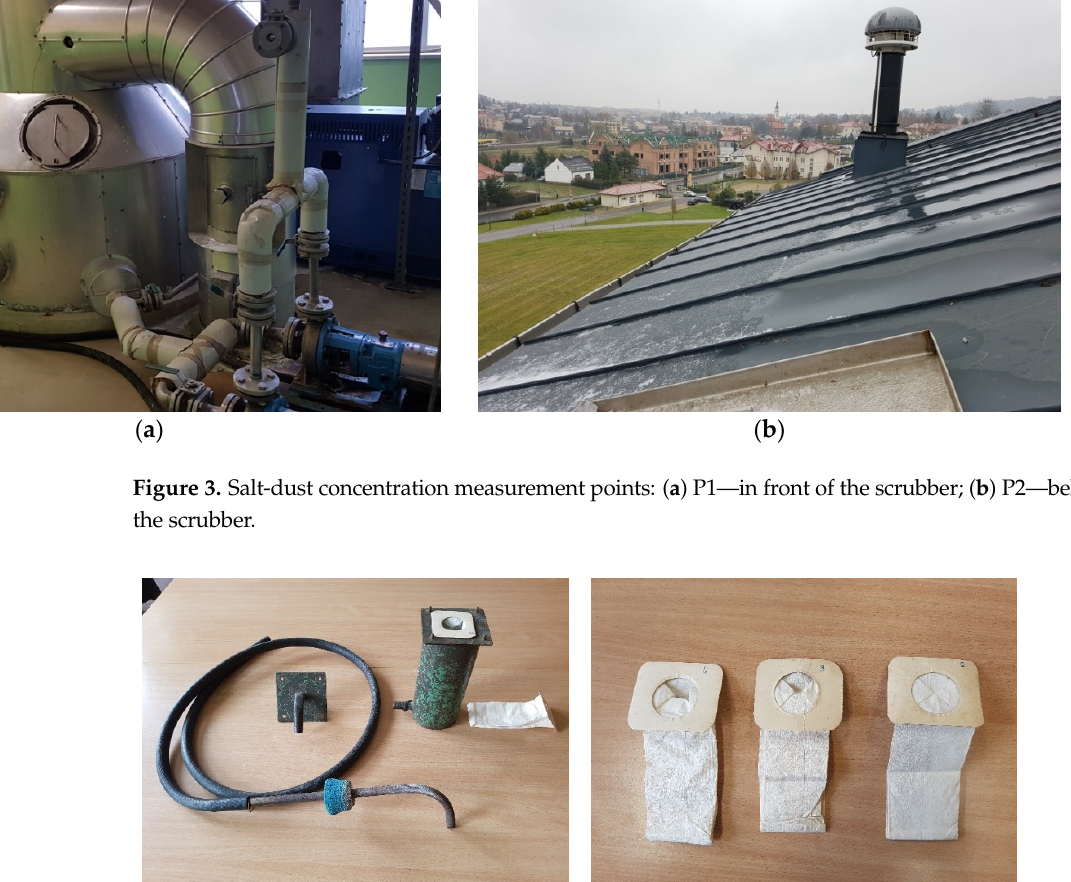
Figure 4. Salt-dust measuring instruments: ( a ) probe and selector; ( b ) measurement filters.